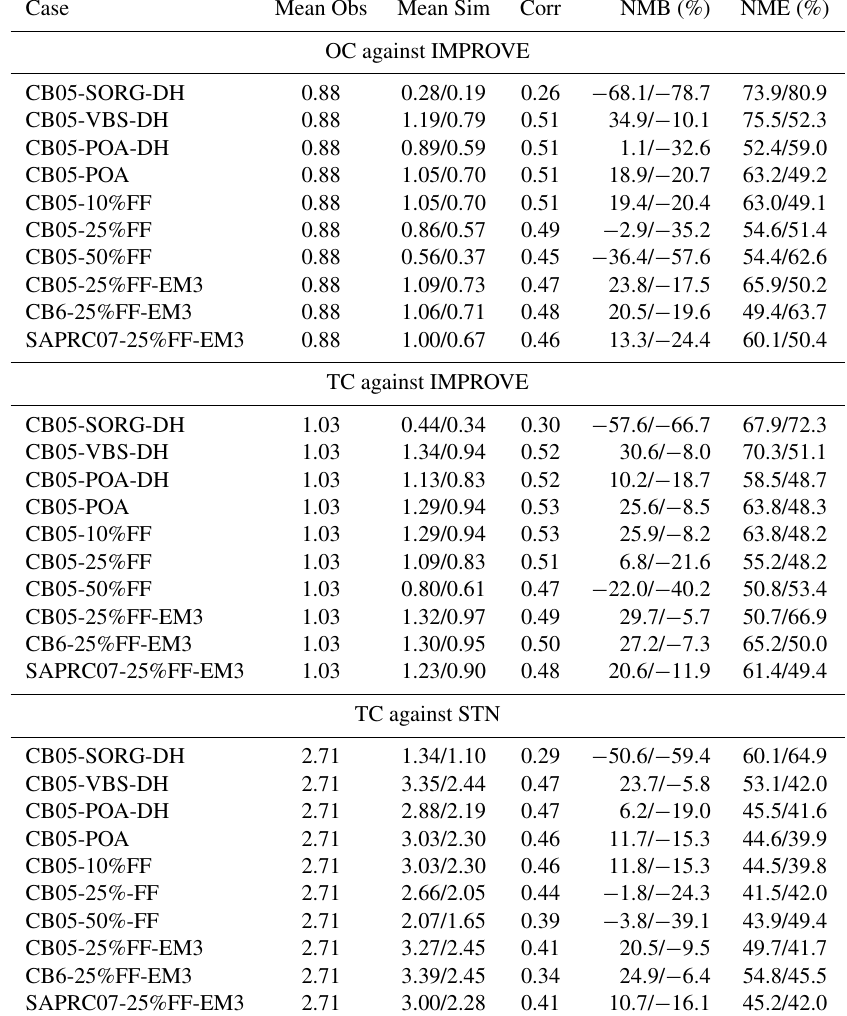
Table 5. Range of statistics for OA / OC ratios of 1.4 and 2.1 (1.4/2.1) for May to June 2010. All simulations use the ARG00 aerosol activation scheme and the Grell–Freitas cumulus